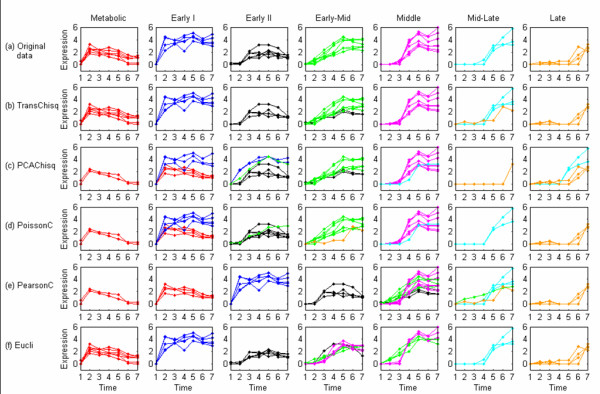
Clustering results for the yeast sporulation data. (a) Original expression profiles of the 39 representative genes from 7 functional groups, (b)-(f) Expression profiles of the 7 clusters produced by different clustering algorithms. The x-axis represents different time points of 0h, 0.5 h, 2 h, 5 h, 7 h, 9 h, 11.5 h. The y-axis represents the normalized log-ratio expression levels.